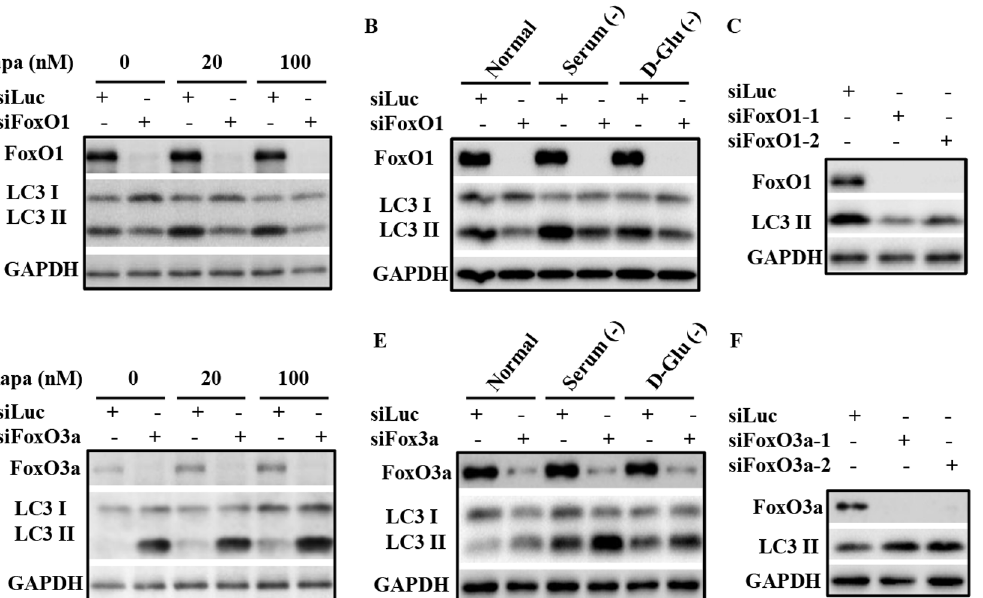
Fig. 1. FoxO3a knockdown induces, while FoxO1 knockdown inhibits, autophagy. (A) Immunoblot analysis of lysates from PC3 cells transfected with control siRNA (siLuc) or that targeting FoxO1 (siFoxO1), with or without rapamycin treatment. PC3 cells were transfected with the indicated siRNA for 48 h before subsequent treatment with DMSO, 20 nM or 100 nm rapamycin (Rap) for 24 h prior to harvest and processing. (B) PC3 cells were transfected with the indicated siRNA for 48 h prior to media change, whereupon the cells were subjected to the indicated growth conditions; these conditions are DMEM in the presence (Normal) or absence of 10% FBS (serum -), or in the absence of D-glucose (with 10% FBS), as indicated. Cells were harvested 6 h after exposure to these conditions, and processed for immunoblot analysis of the indicate proteins. (C) Knockdown of FoxO1 with two targeting siRNAs suppresses autophagy in PC3 cells. (D, E, F) illustrate similar study procedures as (A, B, C), but with siRNAs targeting FoxO3a in PC3 cells. All experiments have been performed three times with similar